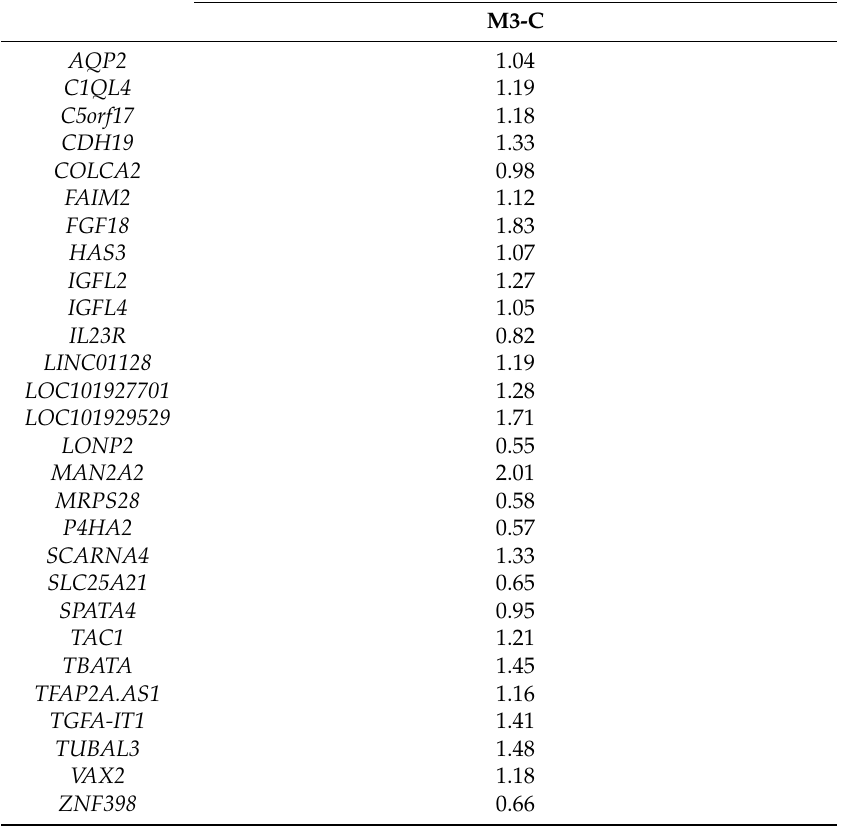
Table A3. Details of individual weights for gene expression. For individual scores, multiply the log2 transformed and normalized gene expression by the weight in the table. Each model has different